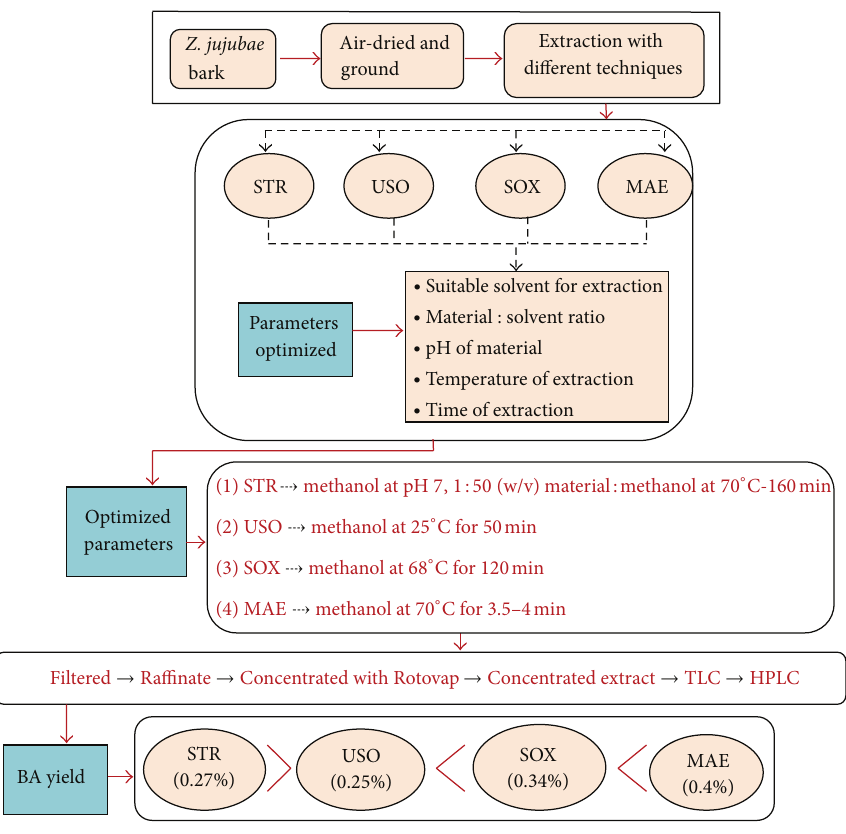
Figure 6: Representation of the complete process for recovery of BA from the bark of Z. jujubae (STR: stirring extraction; USO: ultrasonic extraction; SOX: soxhlet extraction; MAE: microwave assisted extraction).